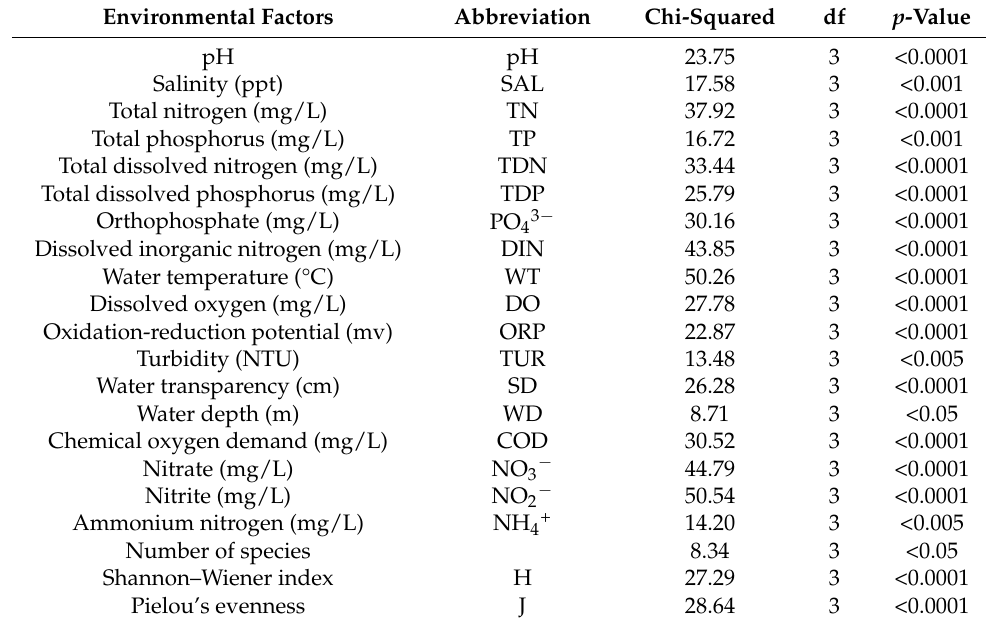
Table 1. The Kruskal–Wallis test results of seasonal variations of environmental factors, number of species, Shannon–Wiener index, Pielou’s